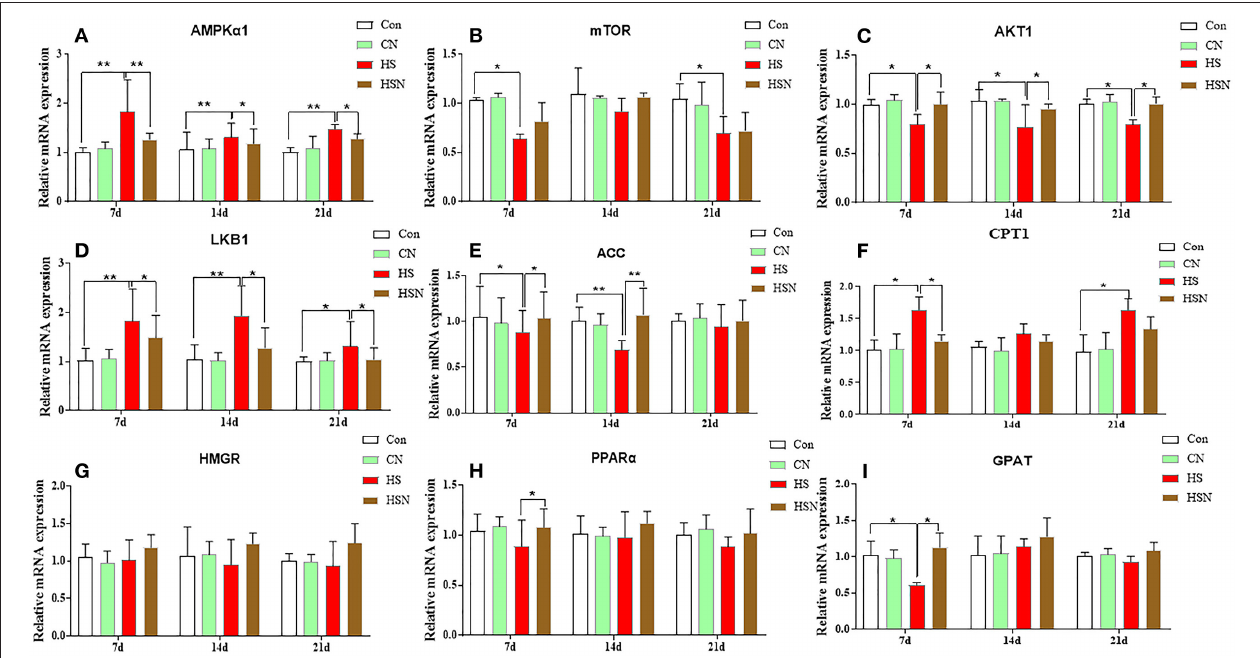
FIGURE 3 | Effects of NAC and heat stress on the mRNA expression levels of AMPK pathway-related genes in the hypothalamus. (A) Expression of AMPK α 1 mRNA. (B) Expression of mTOR mRNA. (C) Expression of AKT1 mRNA. (D) Expression of LKB1 mRNA. (E) Expression of ACC mRNA. (F) Expression of CPT1 mRNA. (G) Expression of HMGR mRNA. (H) Expression of PPAR α mRNA. (I) Expression of GPAT mRNA. * P < 0.01; ** P <